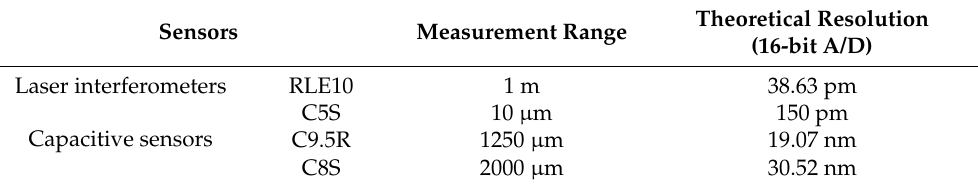
Table 6. Specifications of the sensors.